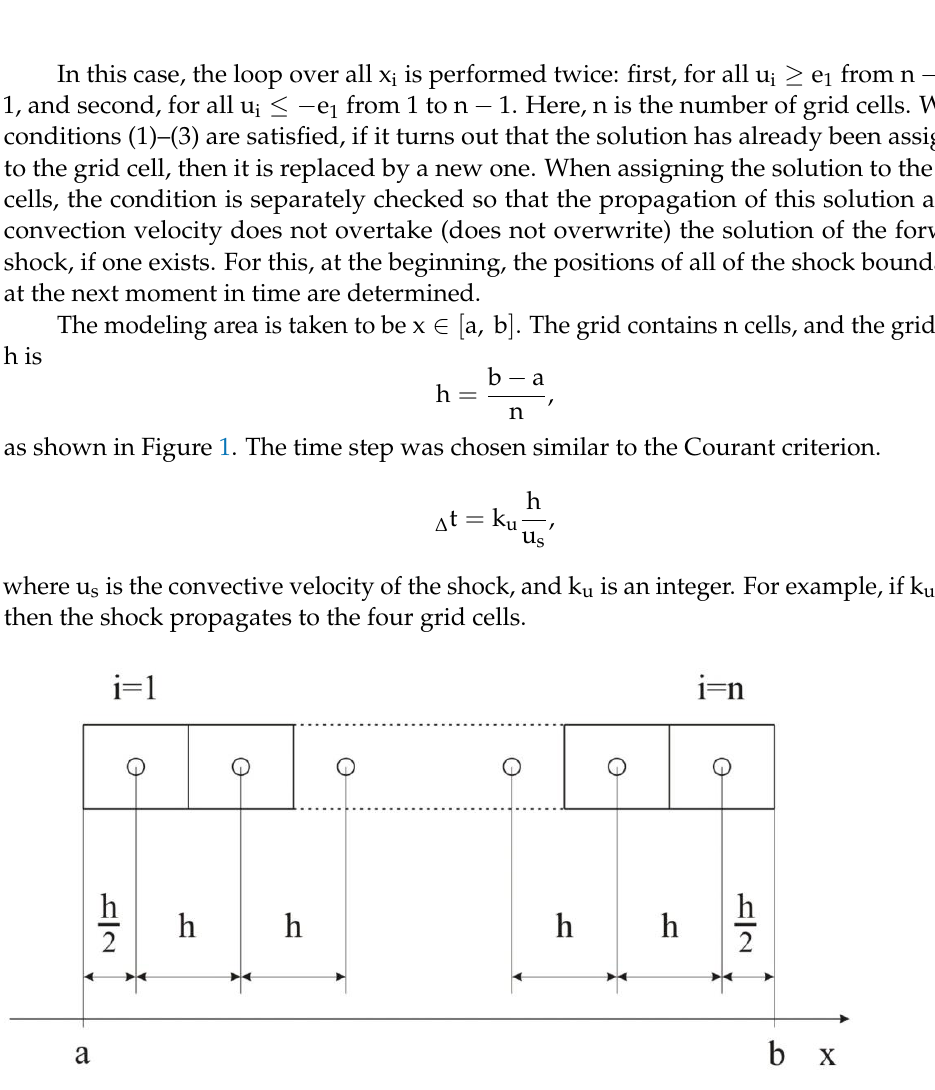
Figure 1. The modeling area and the grid of the proposed method.